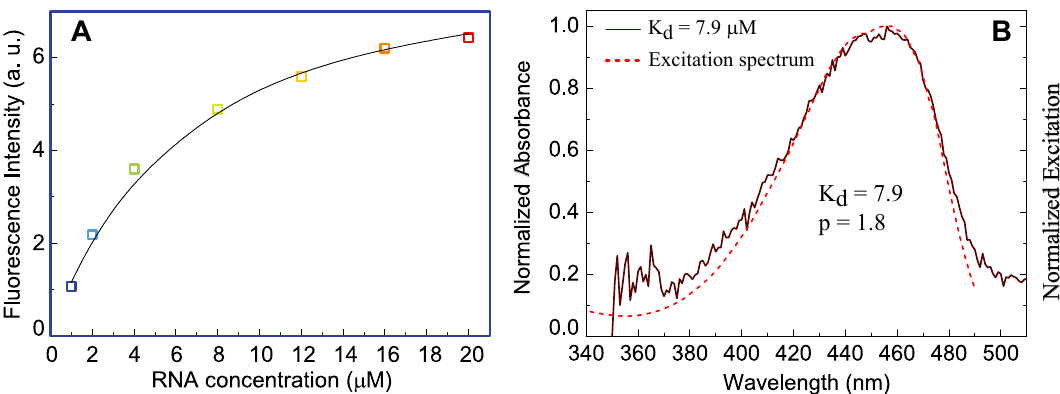
Figure 2. (A) Comparison of experimental and calculated fluorescence intensity. The continuous line represents the best fit of the experimental data to the multiple-site model. (B) The normalized calculated absorption spectrum of the DFHBI/bSP complex derived with K d = 7.9 µM in comparison to the observed fluorescence excitation spectrum (Fig.